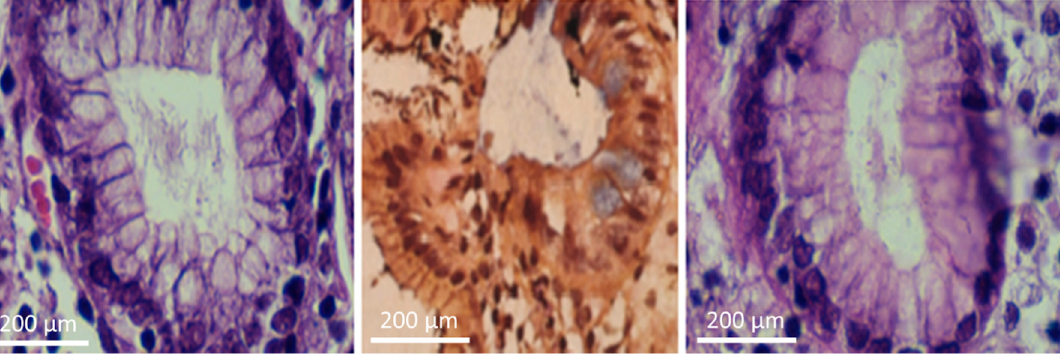
Figure 8. Antral mucosa showing with high ‐ power photomicrograph with focal intestinal meta ‐ plasia (goblet cells stained with alcian blue at pH 2.5), heavy H. pylori infection (spiral bacteria